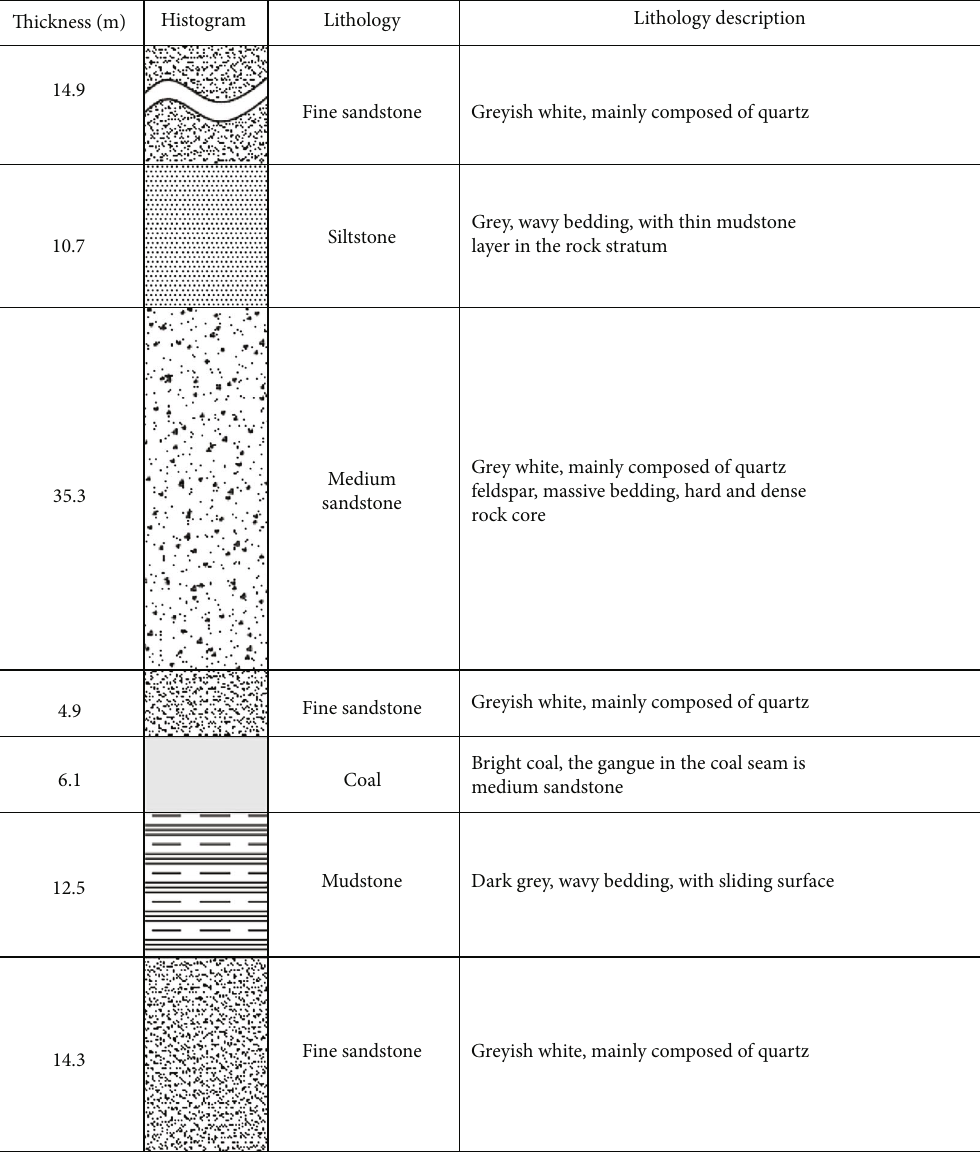
Figure 4: Rock stratum